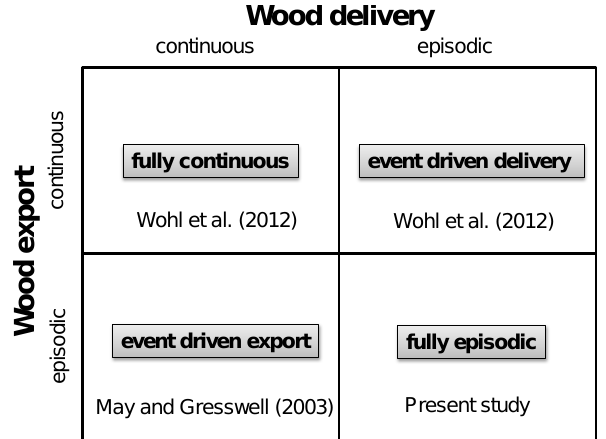
Figure 9. Four-end-member model of LWD dynamics based on wood delivery and export. The models of Wohl et al. (2012), May and Gresswell (2003) and of the present study are placed in a tem- poral continuum of LWD delivery and